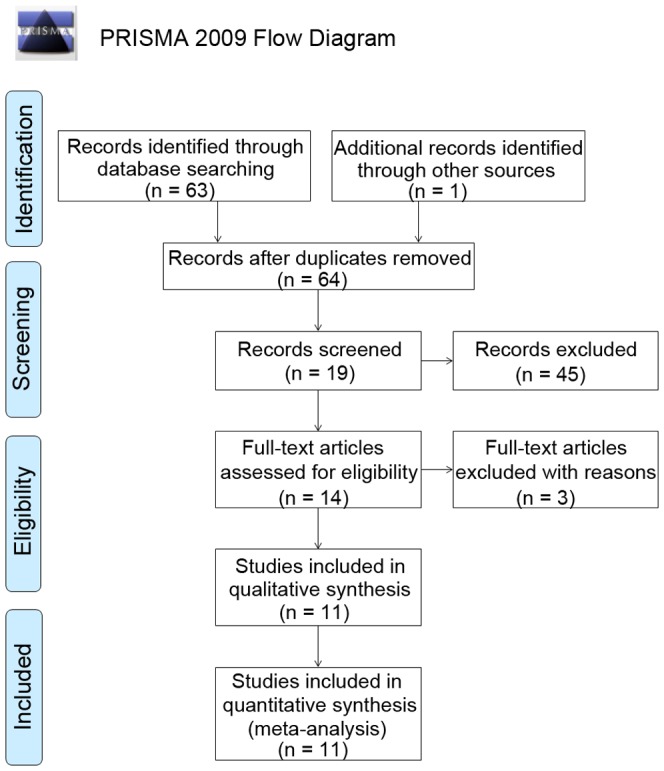
Flow chart of study selection.